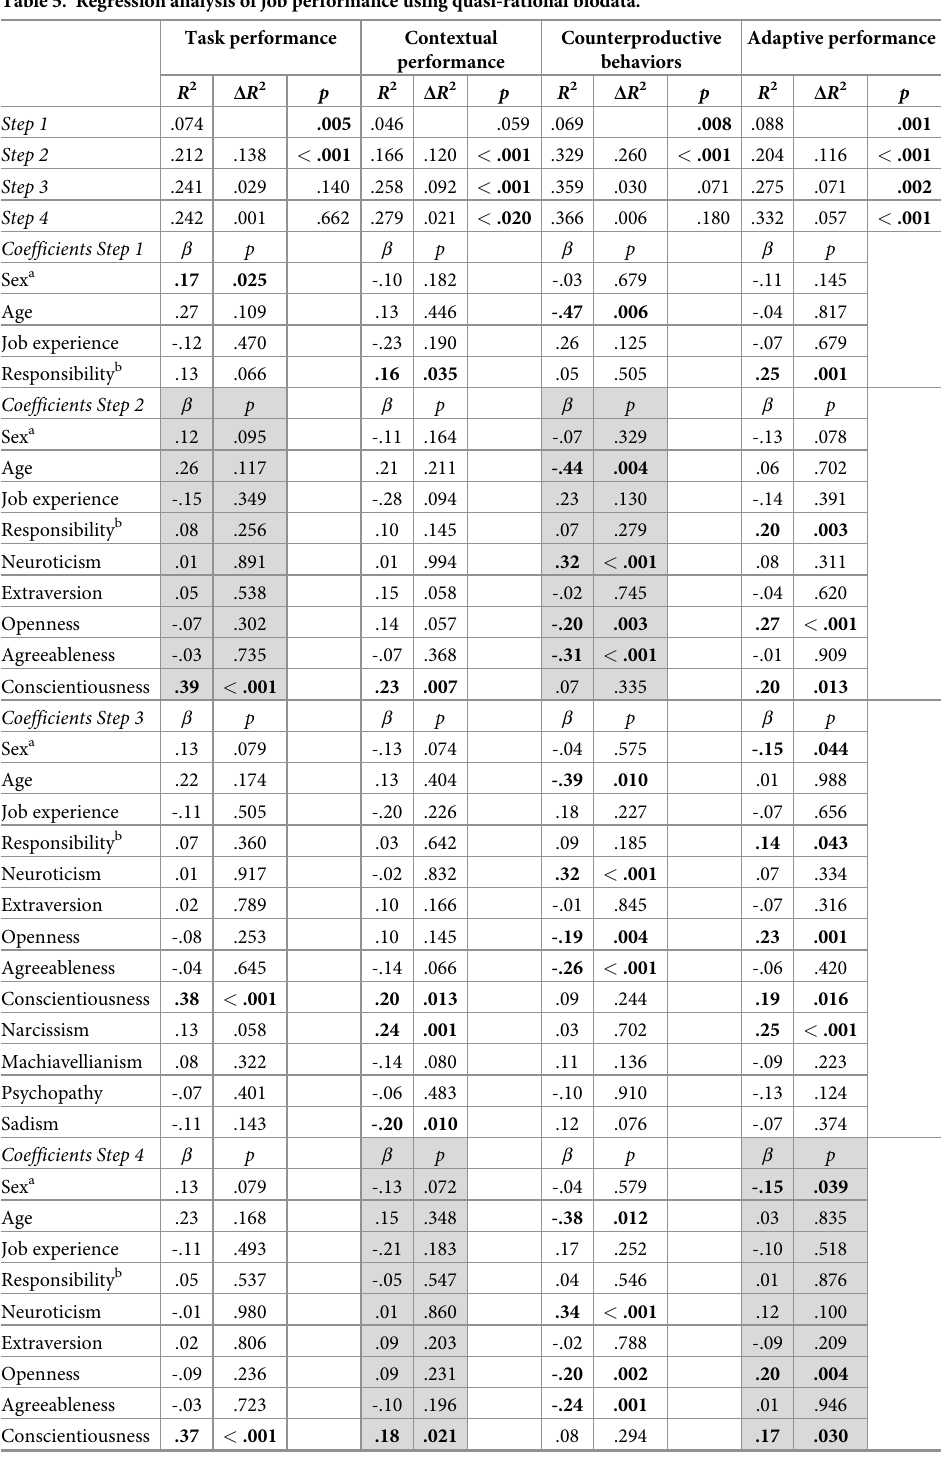
Table 5. Regression analysis of job performance using quasi-rational